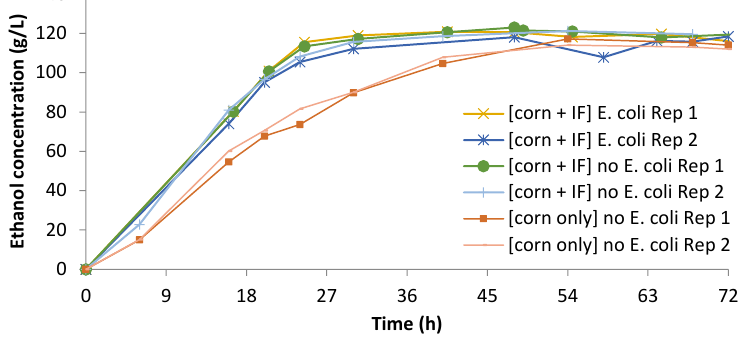
Figure 5. Ethanol production (g/L) from corn alone and corn-IF slurries with and without the addition of E. coli KO11 after 48 h of fermentation with S. cerevisiae . IF: insoluble fiber.